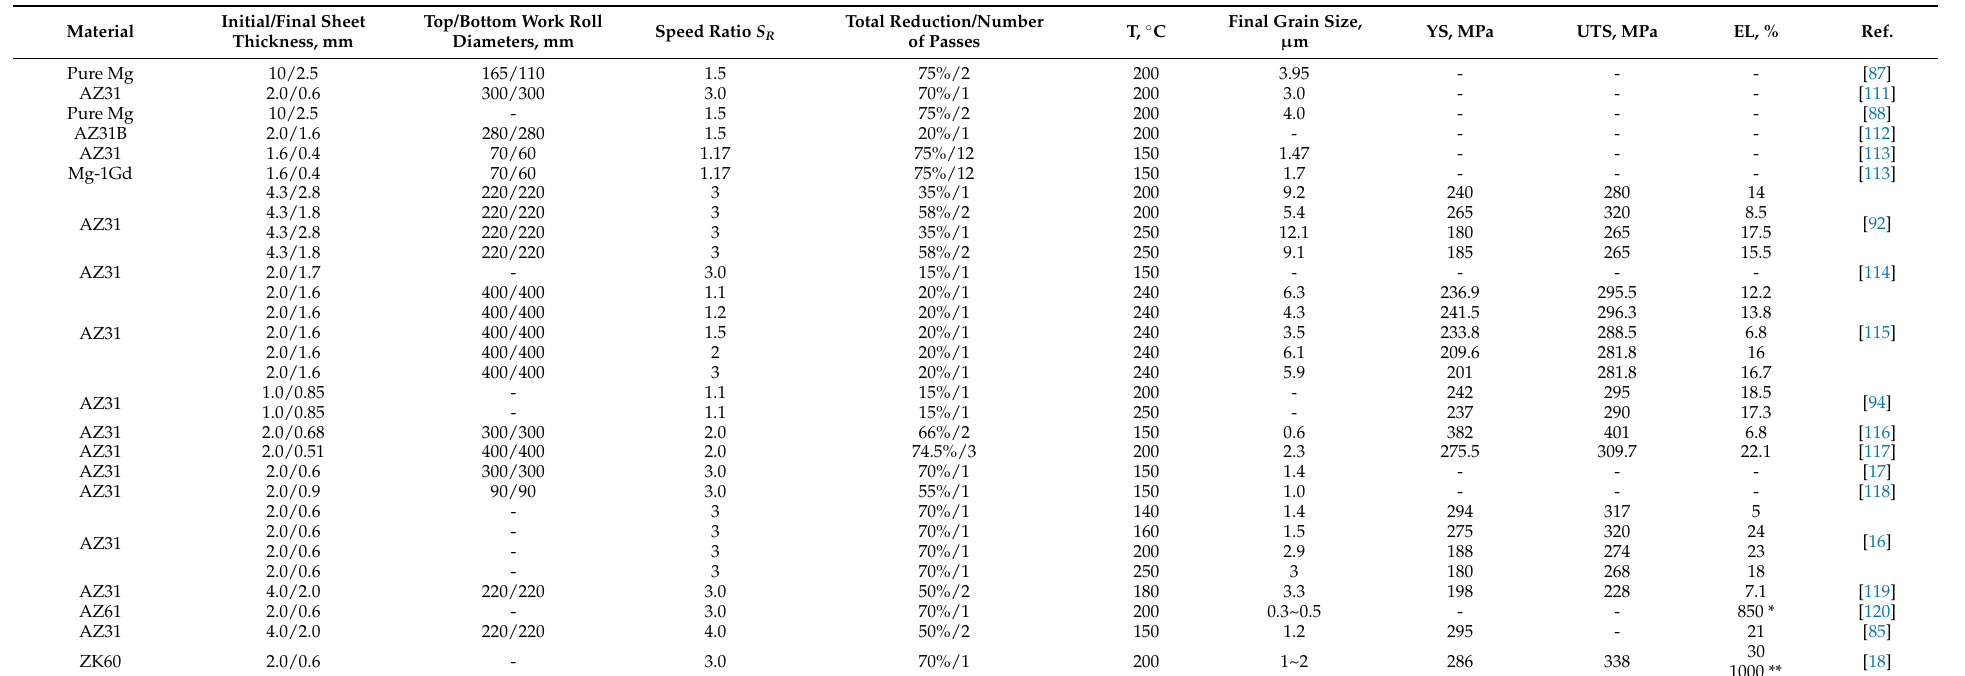
Table 3. Experimental data related to asymmetric warm rolling of Mg alloys.